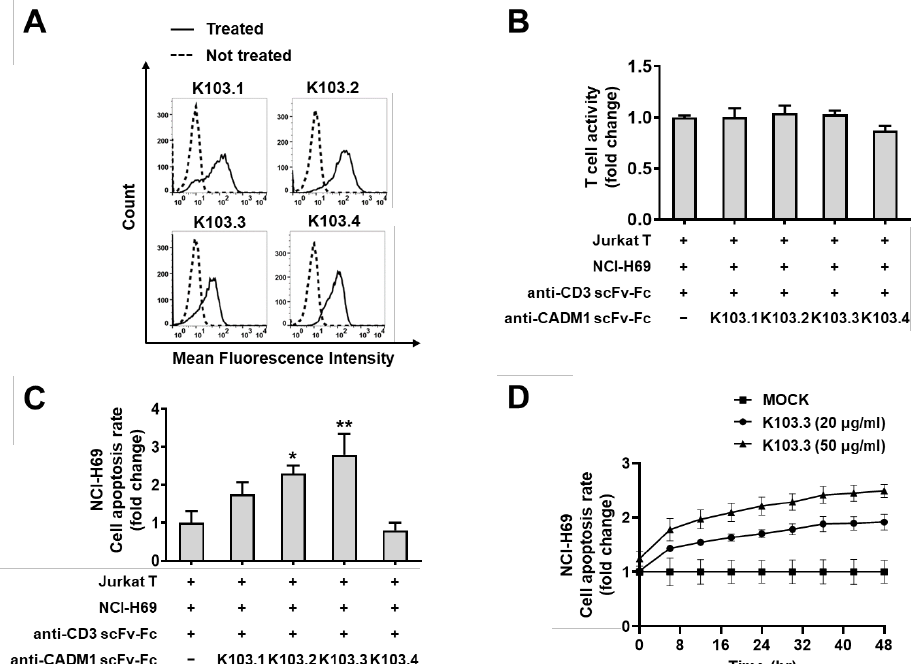
Figure 5. Effect of the selected scFv-Fc antibodies on death in NCI-H69 cells by activated Jurkat T cells. ( A ) The binding of the selected antibodies to MF-CADM1 on NCI-H69 cells was investigated in the presence (solid line) or absence (dashed line) of the selected antibodies using flow cytometry. ( B ) T cell activity was compared by measuring the fluorescence of GFP expressed in activated Jurkat T cells in the presence or absence of selected antibodies. ( C ) The death rate of NCI-H69 cells using the activated Jurkat T cells in the presence or absence of the selected antibodies, respectively. ( D ) Antibody concentration-dependent death in NCI-H69 cells was measured. All values represent the mean ± SEM of triplicate measurements from one of three independent experiments. * p < 0.05; ** p < 0.01.